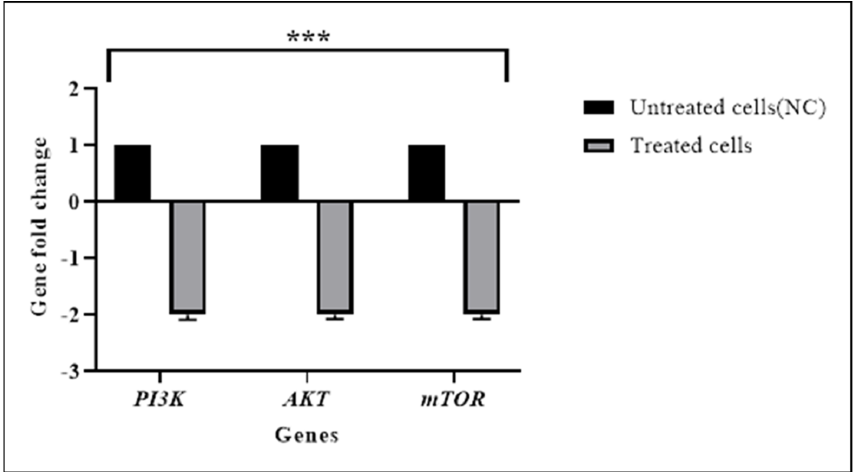
Figure 6. RT − qPCR results of PI3K , AKT , and mTOR expression in HL60 cells. The relative normal- ization of RT − qPCR showed that TQ significantly downregulated the expression of the targeted